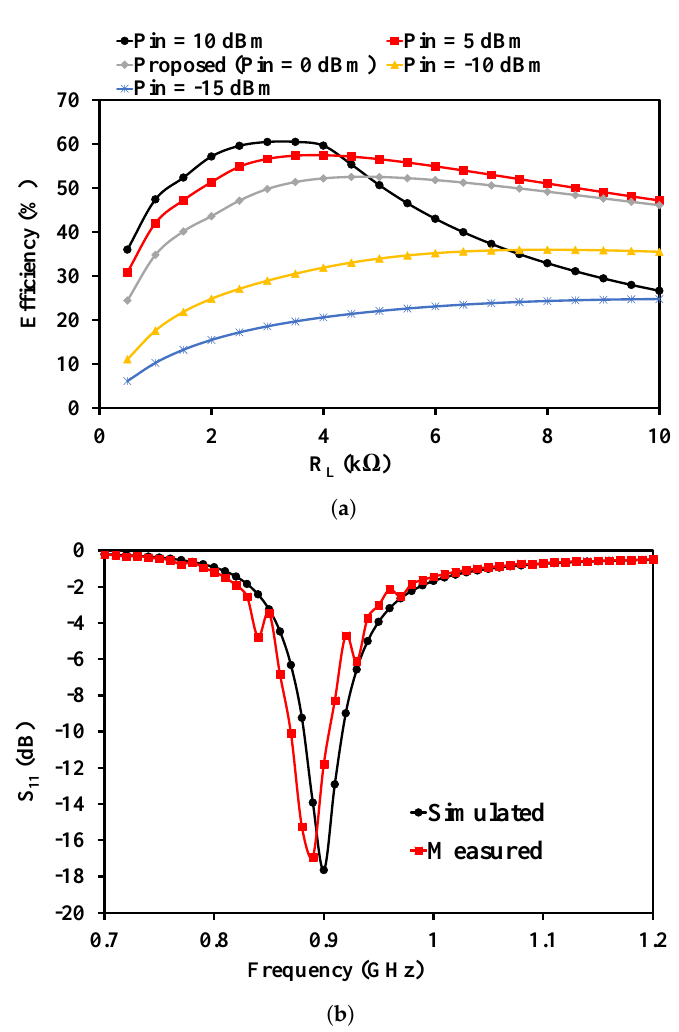
Figure 5. ( a ) Simulated efficiency sweep against load terminal ( R L ) at various input power ( P in ). ( b ) Simulated and measured reflection coefficient of the proposed rectifier for − 20 dBm input